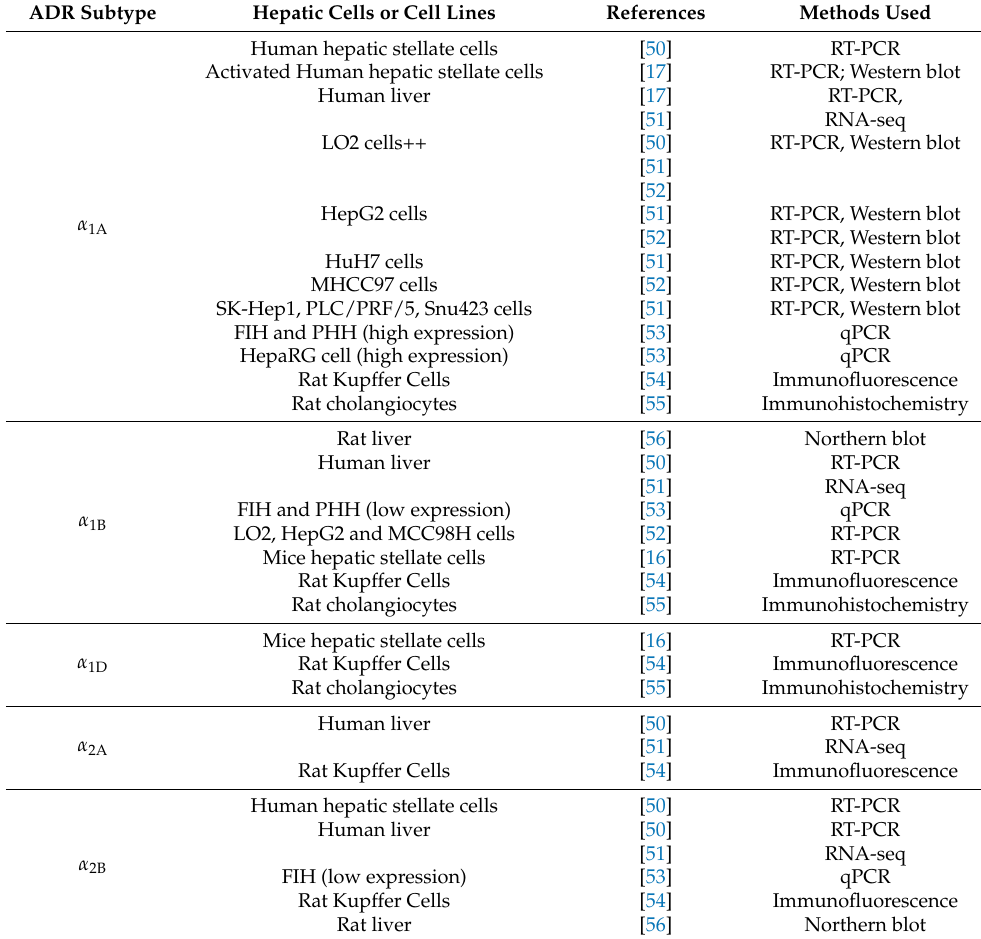
Table 2. Adrenoceptors expression in liver